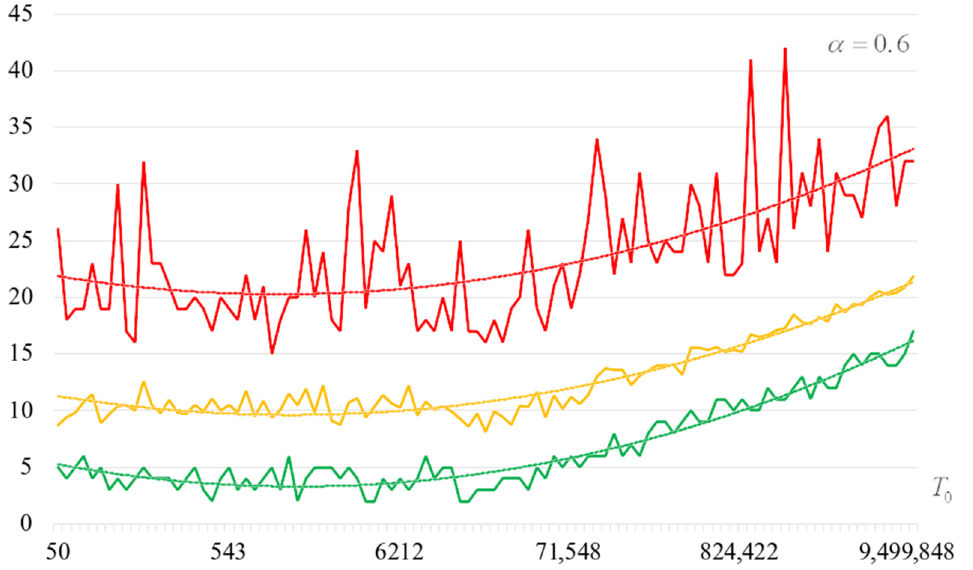
Figure 14. The dependencies of the number of iterations of the outer loop (until one of the criteria for stopping the algorithm is fulfilled) if the algorithm is successfully started, 𝛼 = 0.6 .